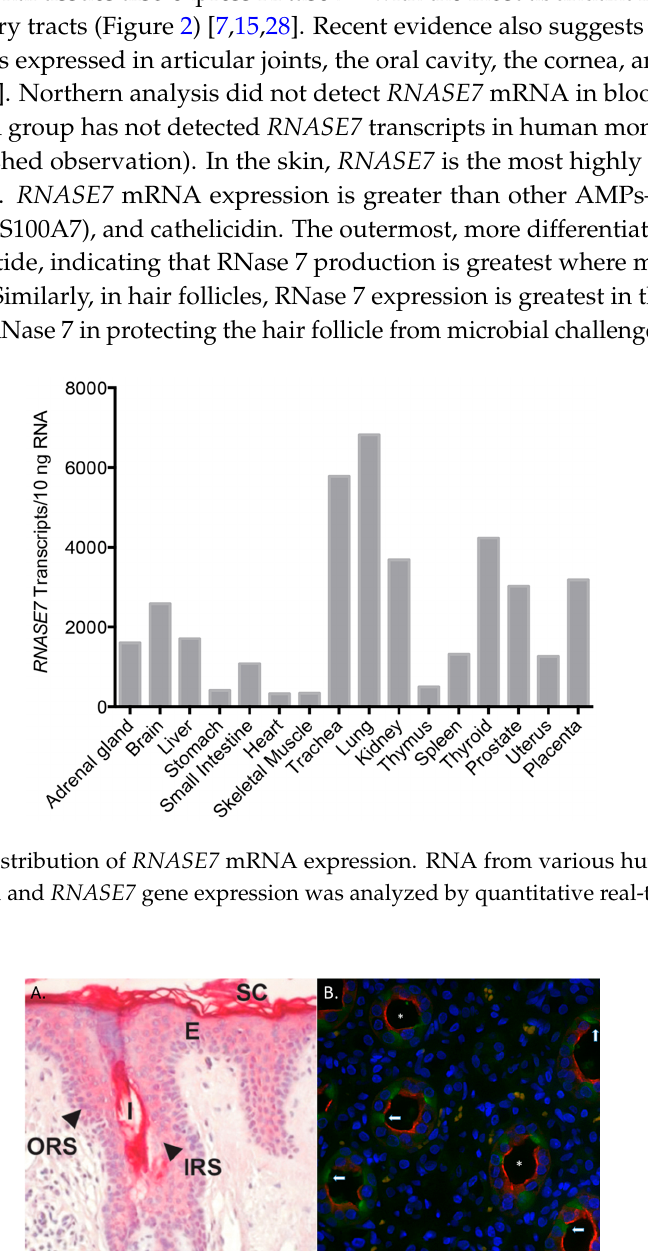
( B ) Immunoflourescence of human kidney labeled for RNase 7 (green/arrows), nuclei (blue), and aquaporin-2 (AQP-2). AQP-2 (red) labels principal cells in the collecting tubule. Principal cells (red) were negative for RNase 7 (green), indicating that the intercalated cells of the collecting tubules produce RNase 7. The asterisk (*) identifies the urinary space. Magnification 40 ˆ